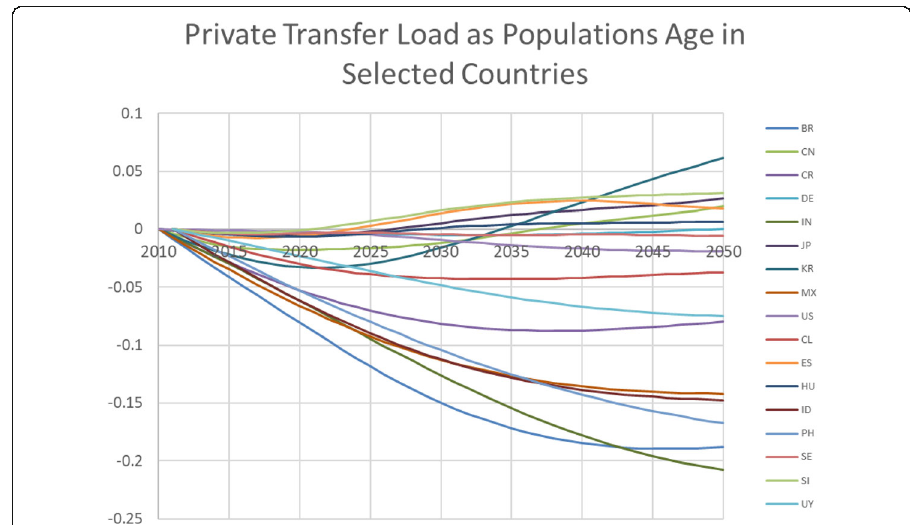
Fig. 10 Change in private transfer load as populations age in selected countries. Note: Private transfer load is the projected increase in private transfers received minus transfers given assuming base period age profiles of these are fixed and the population age distribution varies as projected by the United Nations Population Division (2013). Load is expressed as a proportion of projected aggregate consumption assuming the age profile of consumption is also fixed at base period. Source: Calculated from National Transfer Account age